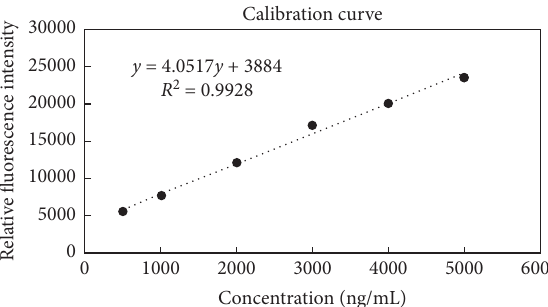
Figure 4: EFN calibrators (500–5000 ng/mL) at emission (299.4 nm) after excitation at 226.5nm after subtracting the blank fluorescence intensity to calculate the relative fluorescence intensity for all samples.